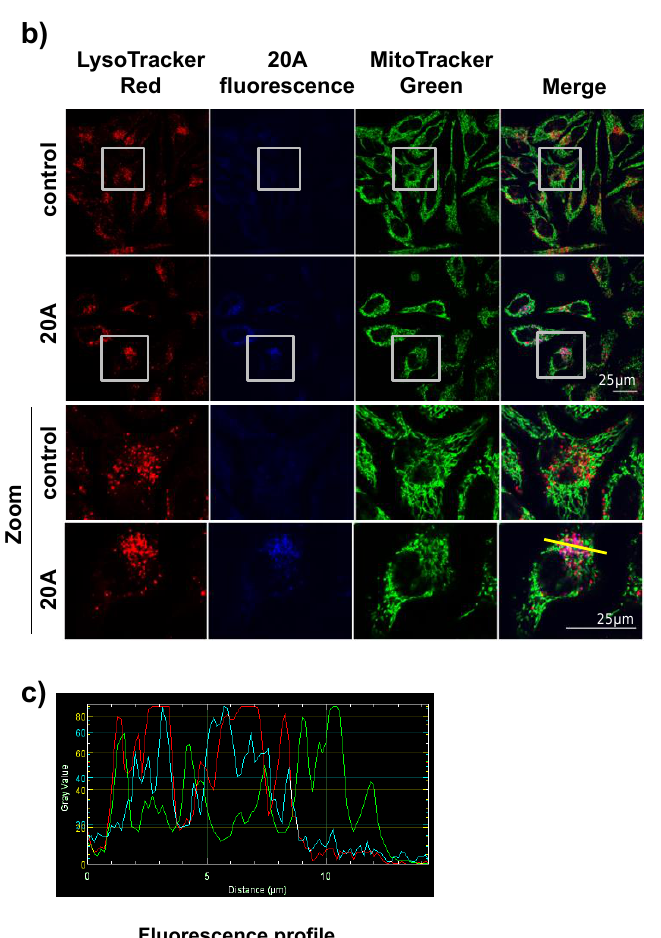
Figure 2. 20A accumulates within the lysosomes and causes lysosomal enlargement. ( a ) HeLa cells were treated with or without 5 µM 20A for 24 h and then stained with LysoTracker Red (red signal) to visualize lysosomes. Left panel, representative confocal fluorescence images are presented for each condition. Right panel, the average of lysosome size was scored for the experiment in (a) using Image J tools ( n > 30 cells /condition, p value * < 0.05 using Mann-Whitney test). Scale bars: 10 µm. ( b ) HeLa cells were treated with or without 5 µM 20A for 6 h and then stained with LysoTracker Red and MitoTracker Green to visualize lysosomes and mitochondria, respectively. Representative confocal images are presented for LysoTracker Red (red signal), 20A fluorescence (blue signal) and MitoTracker Green (green signal). Magnified views of boxes are presented for individual or merged signals. Scale bars: 25 µm. ( c ) The fluorescence intensities of red, blue and green signals plotted along the yellow bar are shown in the “ 20A -treated ” cells panel.